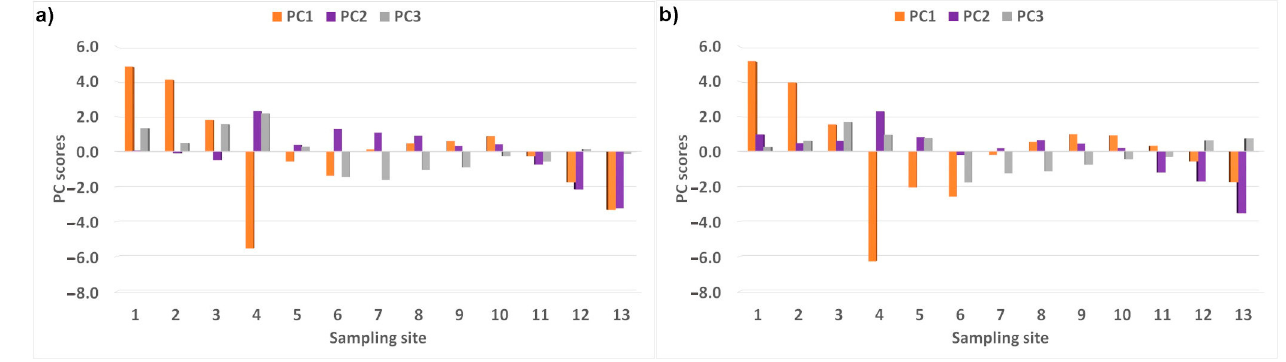
Figure 3. PC scores for the individual sampling points in ( a ) 2018 and ( b ) 2019.